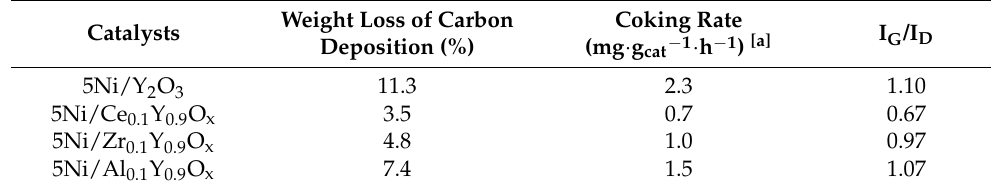
Table 2. Quantified coking results measured by Raman and TGA-DSC.